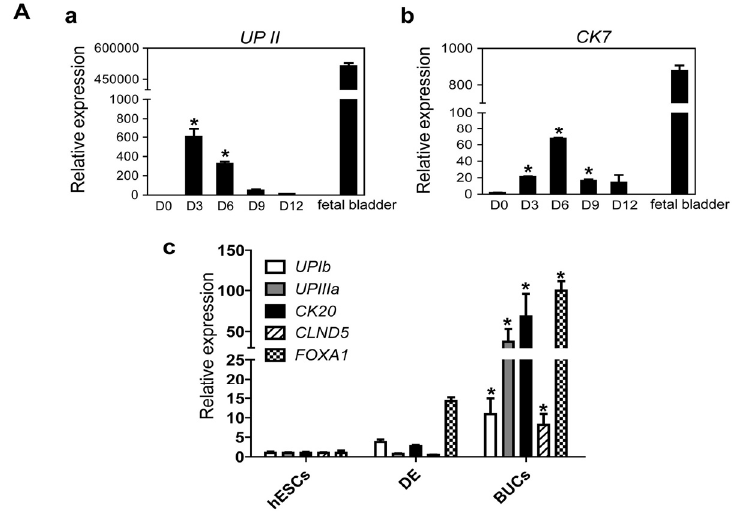
Figure 3. Specification of hESC-derived DE cells into BUCs. ( A ) Optimal timing for induction of BUCs from DE cells was determined by transcriptional expression level of the key marker genes ( a ) UPII (UROPLAKINII) and ( b ) CK7 (CYTOKERATIN 7) , compared to undifferentiated hESCs as a negative control. Human fetal bladder cDNA was used as a positive control (designated as fetal bladder); ( c ) Comparison of transcriptional expression of other urothelial marker genes ( UPIb , UPIIIa , CK20 , CLDN5 and FOXA1 ) between undifferentiated hESCs, DE and BUCs. Relative gene expressions were normalized to GAPDH , and fold changes are shown as mean ± SEM ( n = 3, * p < 0.05); ( B ) Comparison of transcriptional activation levels of ( a ) UPII and ( b ) CK7 at various concentrations of RA (0.1 to 20 μ M). Untreated sample was negative control. Expression levels of transcripts were normalized to GAPDH, and fold changes are shown as mean ± SEM ( n = 3, * p < 0.05); ( C ) Immunocytochemistry for the expression of the key urothelial markers in hESC-derived BUCs. Expression patterns of ( a ) UPII (green); ( b ) CK8/18 (red) and ( c ) both these markers in BUCs. ( d – f ) Determination of superficial and basal urothelial markers expression: ( d ) superficial urothleium marker UPII (green, yellow arrow head), ( e ) basal urothelium marker P63 (red, white arrow head); and ( f ) both these markers in BUCs. Scale bar = 100 μ m; ( D ) Immunocytochemistry for the expression of gap junction molecules E-cadherin (green) and ZO-1 (red) in ( a – c ) DE cells and ( d – f ) BUCs. SOX17 (white) is shown as DE marker and yellow arrow heads indicate SOX17-positive DE cells. White dashed lines designate gap junction molecules-positive regions in BUCs. Scale bar = 100 μ m; ( E ) In vitro permeability analysis of hESC-derived DE and BUCs. ( a ) Schematic illustration of this assay; ( b ) Monolayer staining and ( c ) FITC-dextran permeability testing. Fluorescence intensities were quantified (one second counting time) and shown as mean ± SEM ( n = 3, *** p < 0.001). The no monolayer sample is a negative control. Scale bar = 200 μ m; ( F ) Transcriptional activation of ( a ) OCT4 (pluripotent markers); ( b ) smooth muscle ( CALPONIN and MYF5 ); ( c ) Intestine ( CDX2 and FABP2 ); and ( d ) liver ( AFP and ALB ) were evaluated by q-PCR in hESC-derived bladder urothelium. Relative expression values were normalized to GAPDH , and fold-changes are shown by mean ± SEM ( n =